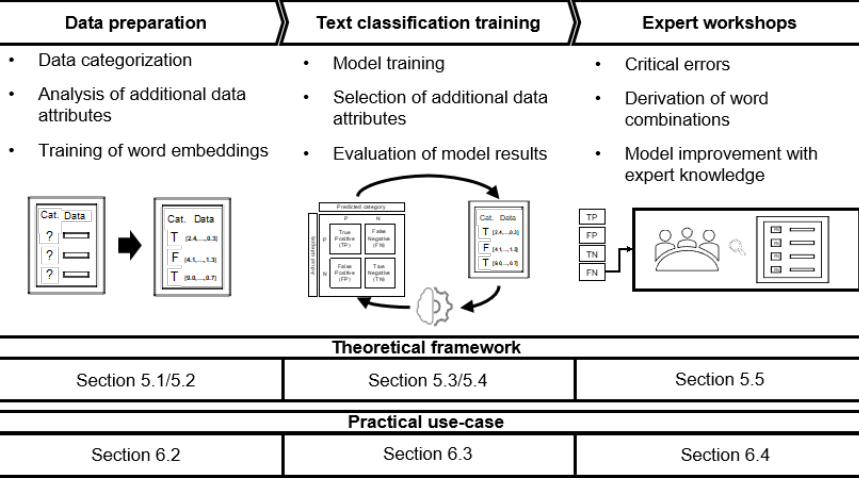
Figure 4. Overview of methodology.